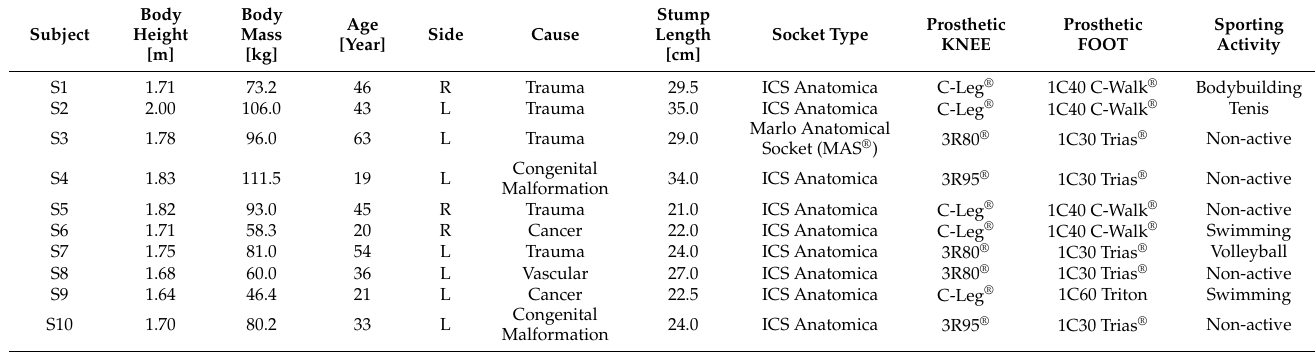
Table 1. Detailed characteristics of patients’ gender, body height, mass, age, and type of prosthesis. Regular sporting activity for the active group was